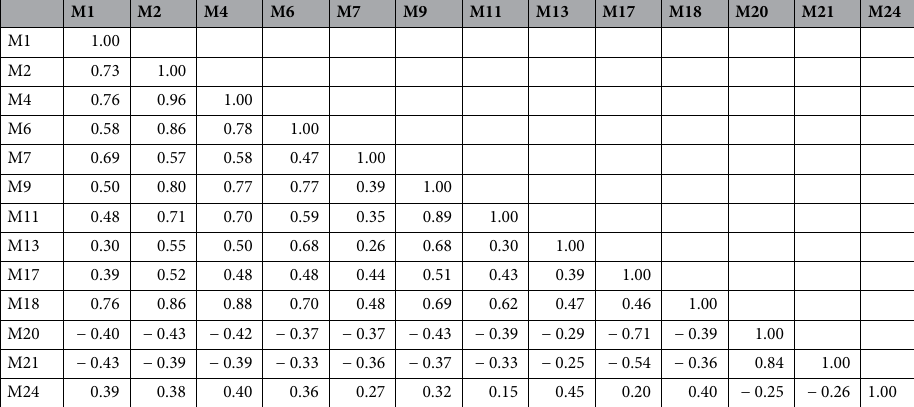
Table 3. Correlation analysis results for 13 candidate metrics.